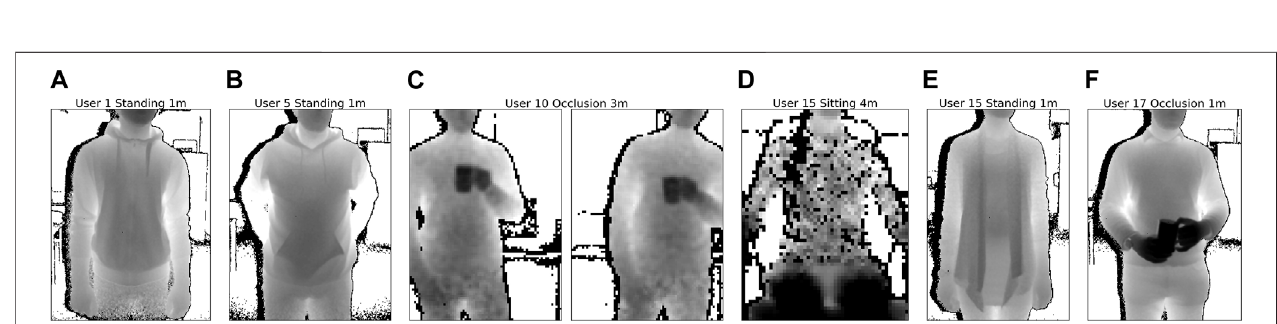
FIGURE 11 | Example images from the recordings of (A – F) user 1, user 5, user 10, and user 17. Their clothing is particularly challenging for different types of methods. Difference based methods have dif fi culties when the throat is partially covered by a collar (user 1, user 5, and user 17), resulting in a poor motion reference signal obtained from the throat region. Clothing with bad infrared re fl ection properties (user 15, left) and garments loosely hanging from the chest or the shoulders (user 15, right) or similar clothing that causes many surface deformations over time, like ribbons reaching to the chest area (users 1 and 5), are likely to interfere with the respiration signal obtained from all methods. Also hair covering the body surface (user 15, left) or users moving a lot or bending to either side (user 10) are likely to cause signal distortions.